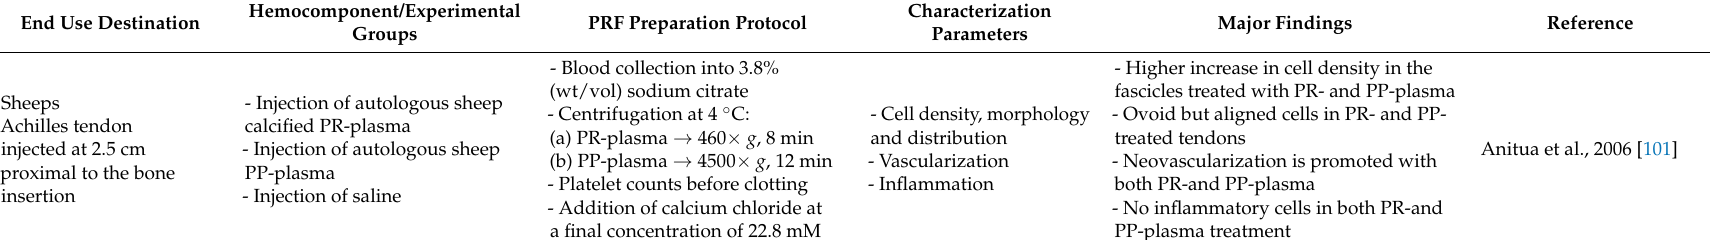
Table 5. Pre-clinical studies on PRF for tendons